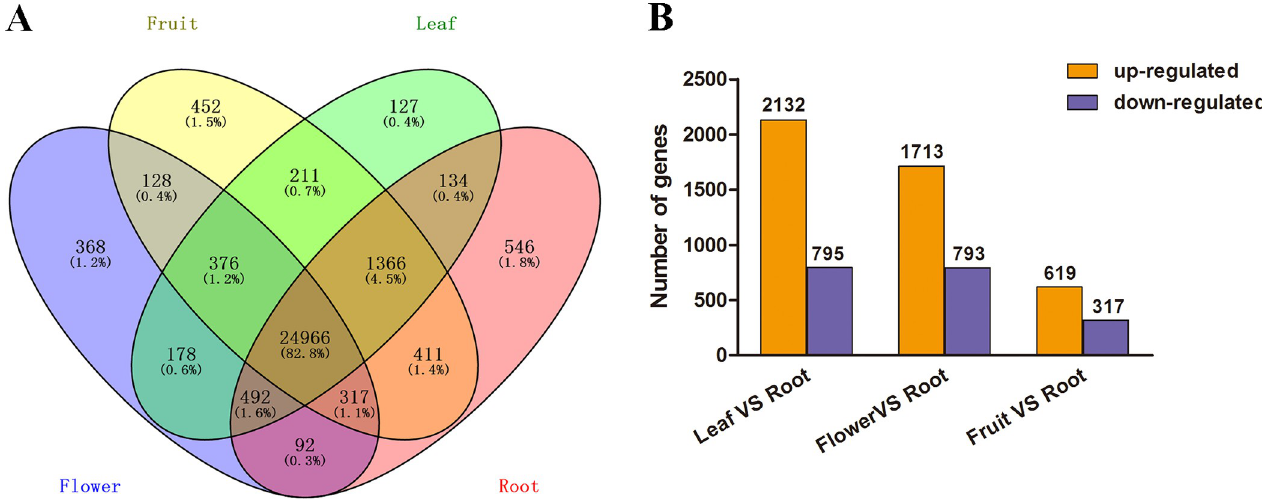
Fig 2. Tissue-specifically expressed genes in Paeonia . (A The spatial expressing patterns of genes in four different tissues, B Number of differentially expressed genes between different tissues).